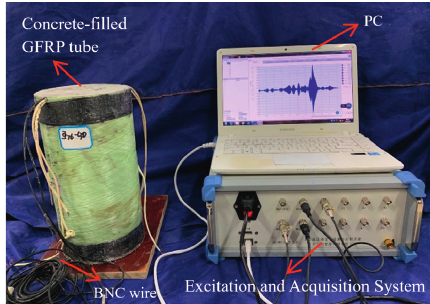
Figure 4: Composition of an active detection system based on piezoelectric